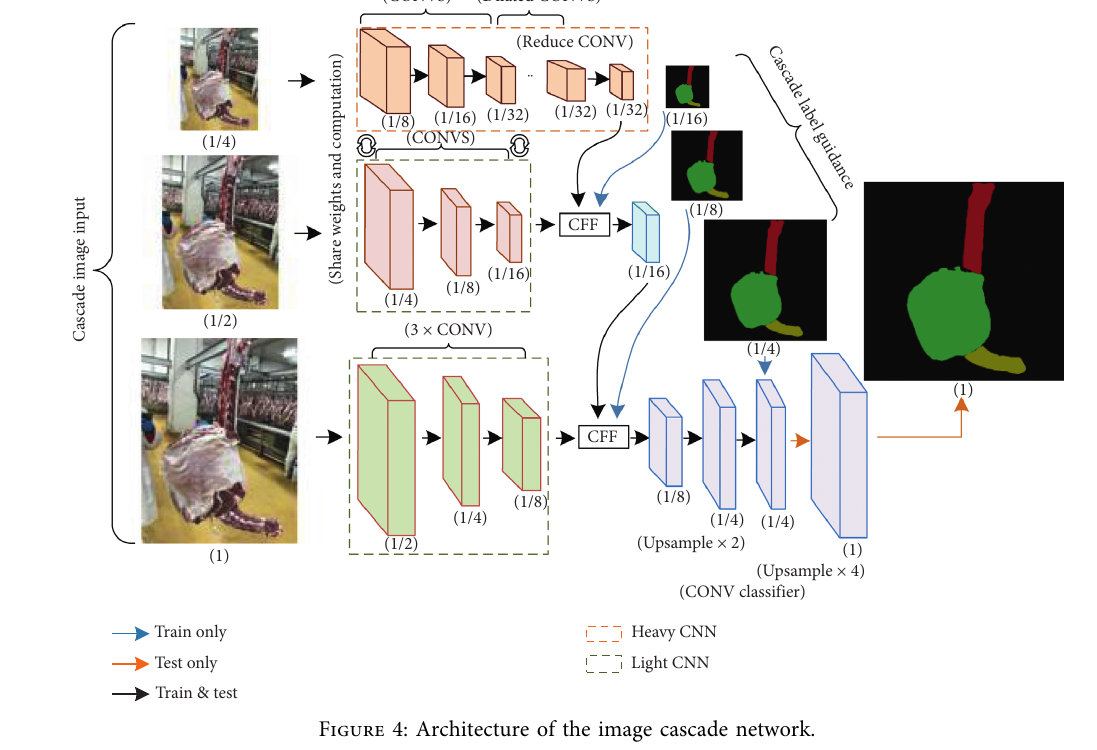
Figure 4: Architecture of the image cascade network.